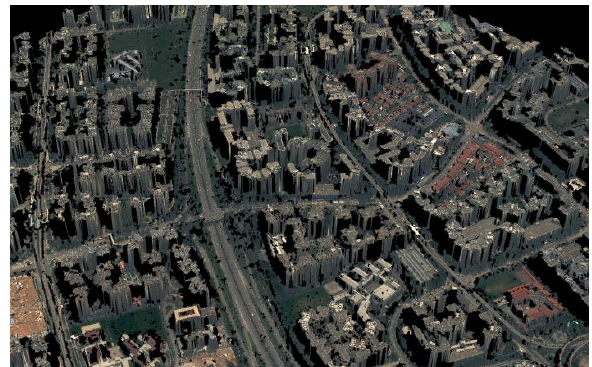
Figure 5. DSM of a worldview-2 dataset generated by